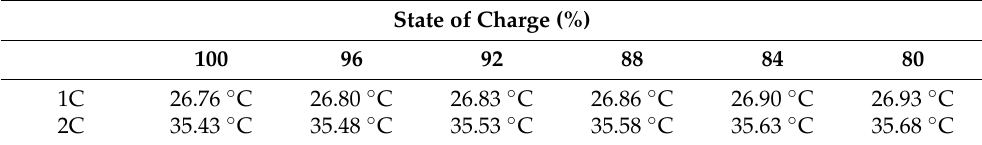
Table 4. Optimal temperature evolution as cell’s aging